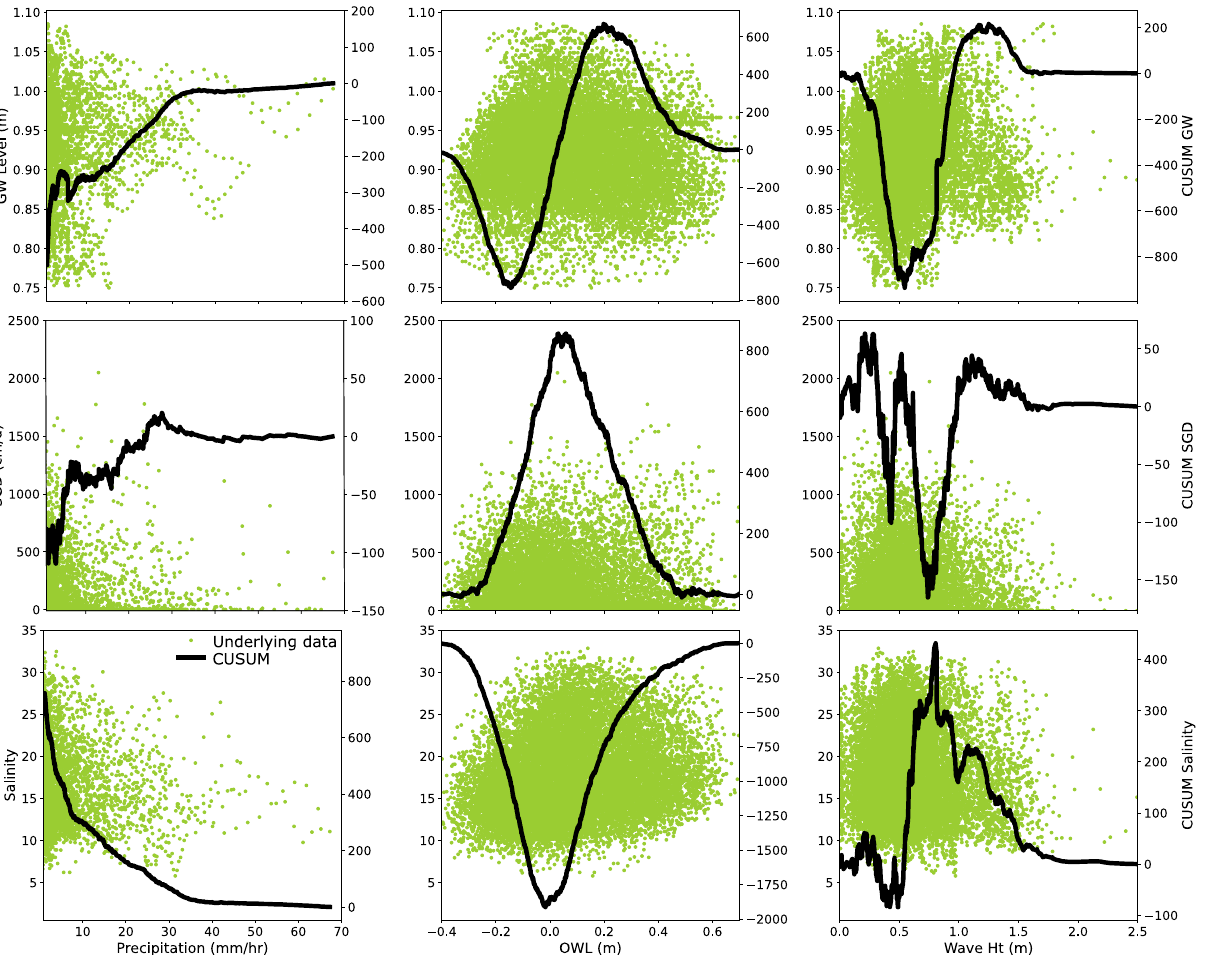
Figure 7. CUSUM driver-response plots (columns = drivers, rows = response). Drivers shown include precipitation rates exceeding 1 mm/hr (mm/hr; column 1), ocean water level (OWL; m with respect to MSL; column 2), and wave height (Wave Ht; m; column 3). These are compared to the following responses: groundwater levels (m; row 1), SGD (cm/d; row 2), and salinity (row 3). The underlying data showing the relationship between x and y are shown in the green dots on the primary y-axis. The driver-response relationship is illustrated with the black line (secondary y-axis), comparing the CUSUM groundwater level, SGD, and salinity vs. precipitation, OWL, and wave